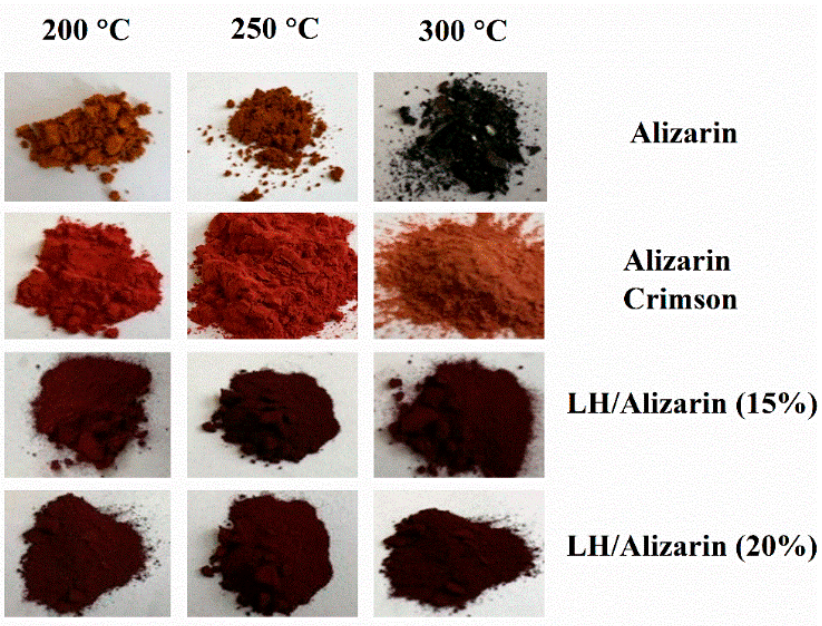
Figure 7. Color changes in alizarin, Alizarin Crimson, and alizarin pigments after thermal aging at different temperatures.